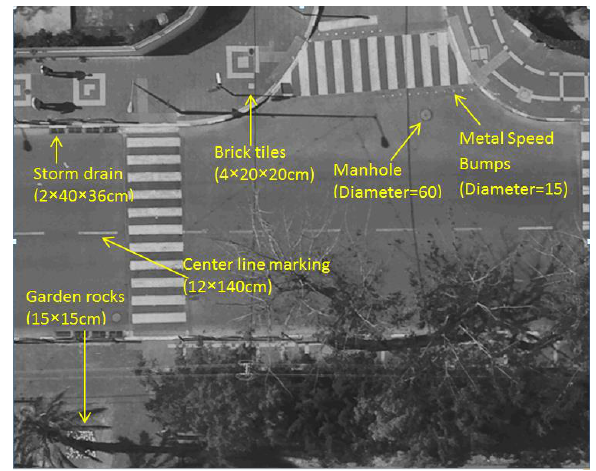
Figure 3: Tests for image interpretability (5cm resolution)